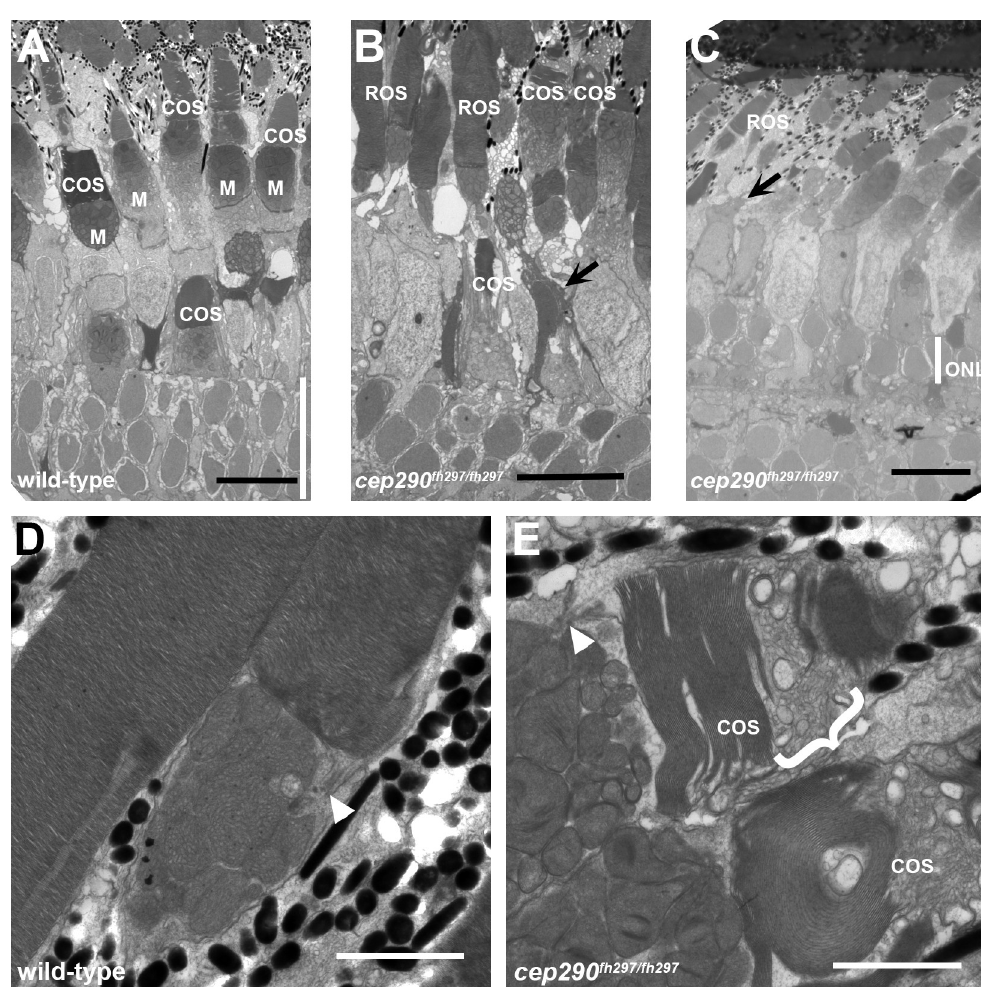
Fig 3. Cone degeneration marked by outer segment disorganization in cep290 fh297/fh297 mutants. (A-C) Transmission electron micrographs of retinal sections from 6 month old wild-type (A) and cep290 fh297/fh297 mutant adults (B, C). Cone outer segments and mitochondria in the ellipsoids are visible in the wild-type retina. In the cep290 fh297/fh297 mutant retinas, cone outer segments are missing or disorganized (arrows) and the outer nuclear layer (ONL, white line) is reduced to 1–2 nuclei. (D, E) At higher magnification, the outer segment disc membranes are tightly stacked in wild-type retinas. In cep290 fh297/fh297 mutants, numerous vesicular structures and disorganized membranes are seen in cone outer segments (bracket). Rod outer segments are largely preserved and the connecting cilia are shown (white arrowheads). Scale bars: 10 μ m (A-C); 2 μ m (D,